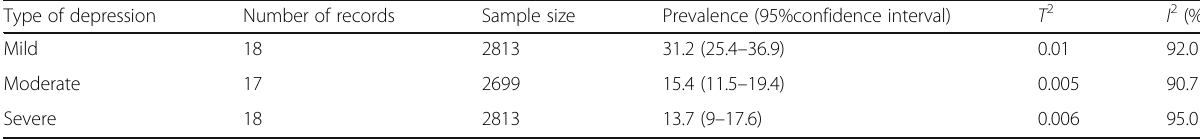
Table 3 The pooled prevalence of mild, moderate, and severe depression among Iranian infertile couples Type of depression